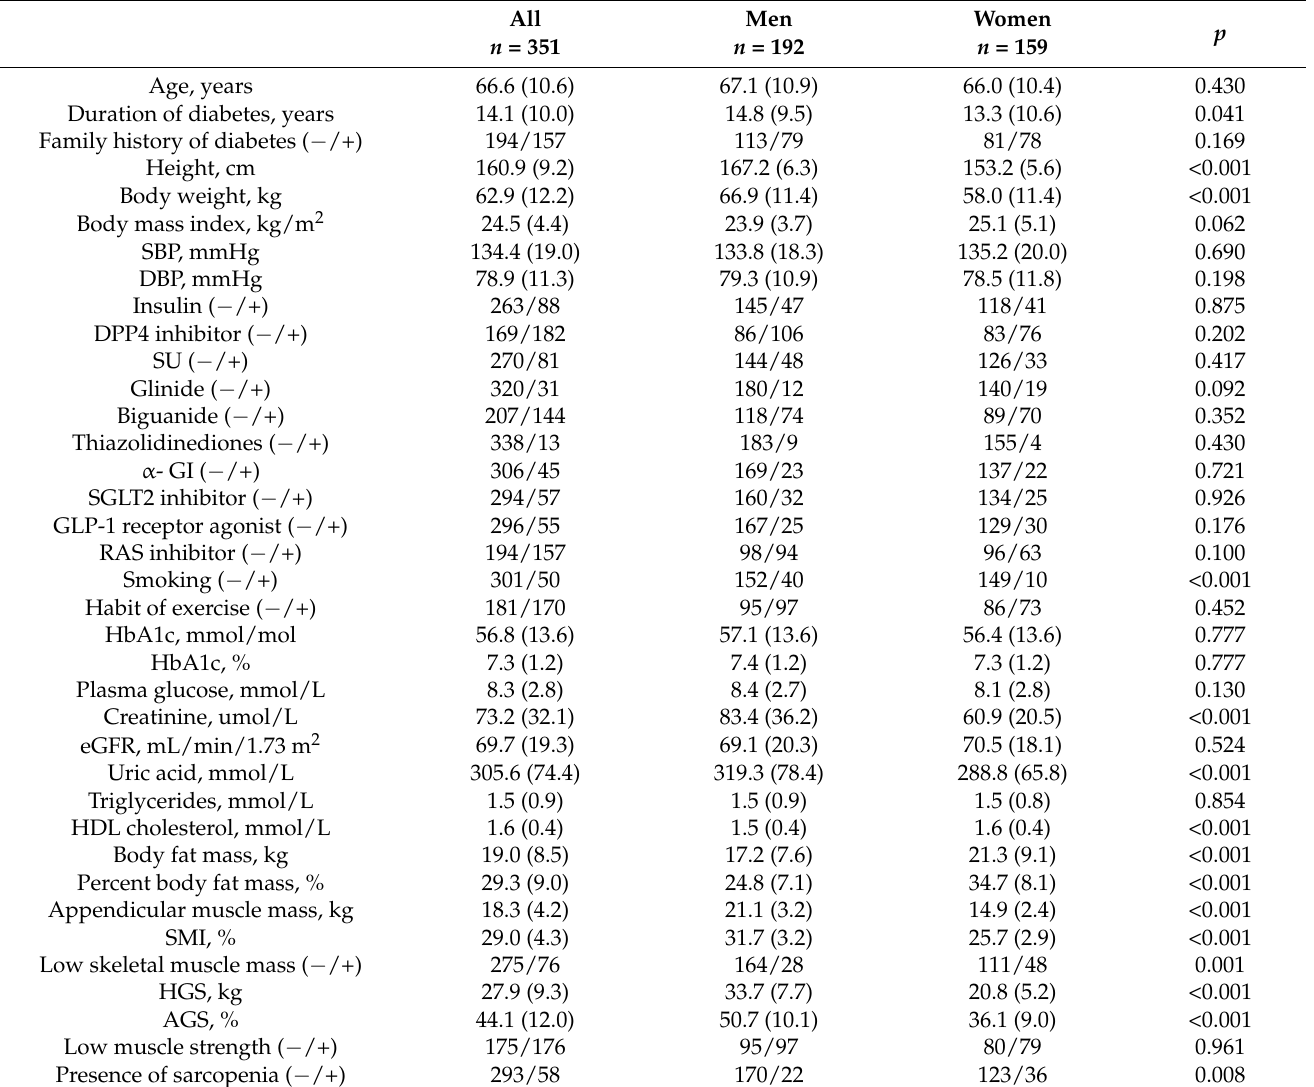
Table 1. Clinical characteristics of study participants.